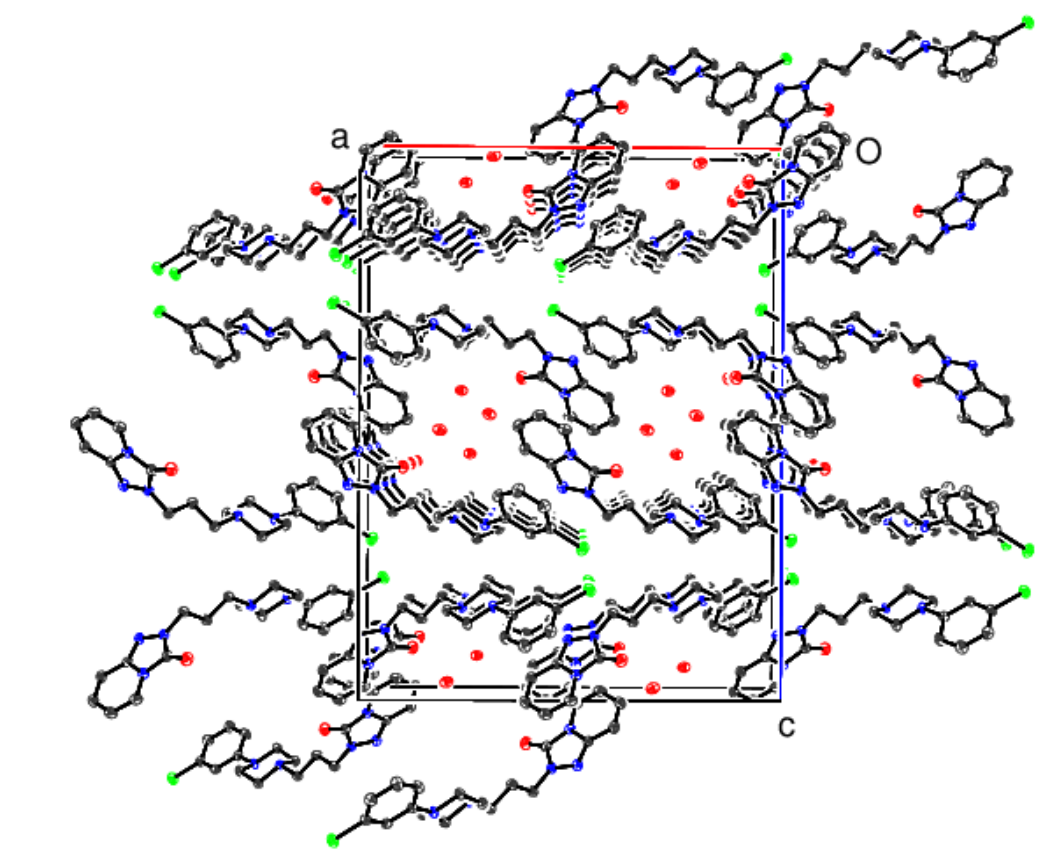
Figure 8. The unit cell packing for γ trazodone dihydrate viewed down [010] with H atoms omitted for clarity.